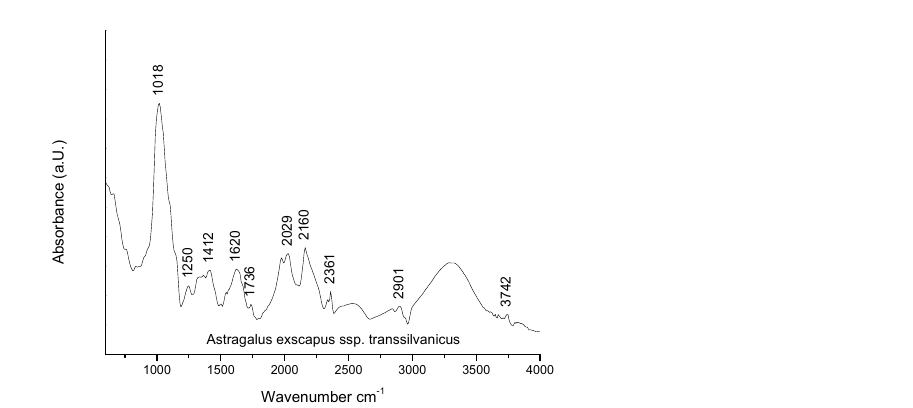
Figure 2. Fourier Transform Infrared spectroscopy profile of ASTRA roots.